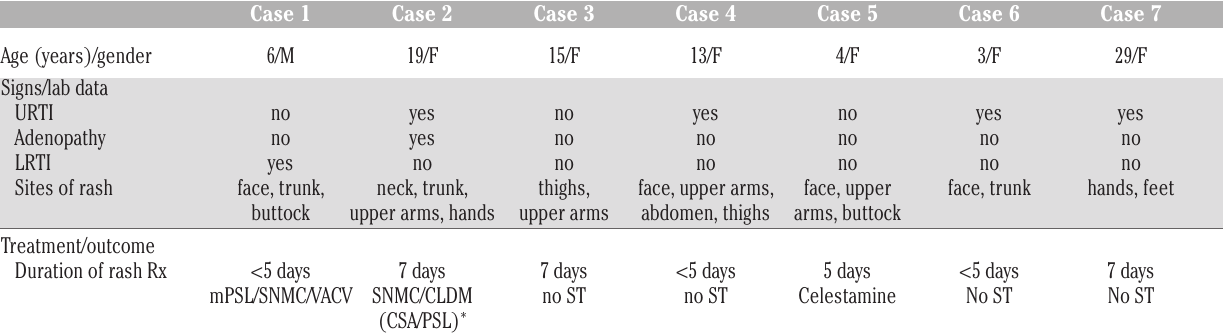
Table 1. Clinical features of 7 cases of Chlamydia pneumoniae (Cp)-related erythema multiforme.